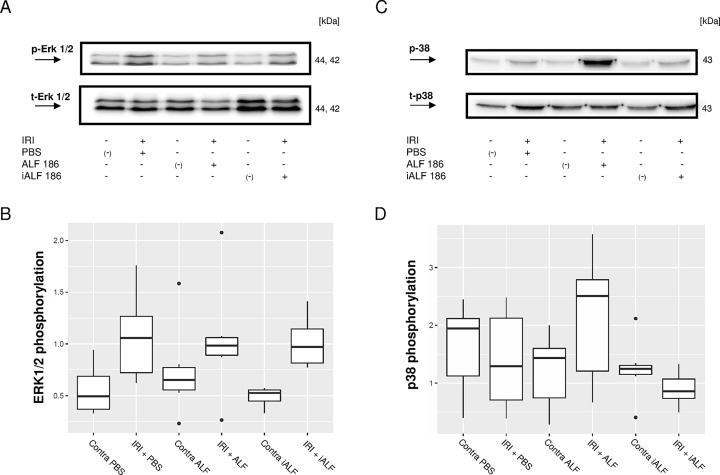
Effect of ALF-186 on mitogen-activated protein (MAP) kinases ERK1/2 and p38.(A) Representative western blot image showing the suppression of phosphorylated ERK1/2 compared to total ERK1/2 after IRI+ALF-186 treatment. The contralateral eye to each treated eye was indicated with (-) to demonstrate, that no MAP-kinase alterations were detectable in and between the right eyes. (B) Densitometric analysis of n = 6 western blots for phosphorylated ERK1/2 after IRI+treatment given in box plots. ALF-186 not affected the IRI-induced upregulation of ERK1/2, which was equally present after PBS, ALF or iALF-treatment, p>0.97. (C) Representative western blot image showing the increase of phosphorylated p38 compared to total p38 after intravitreal ALF-186 treatment. (D) Densitometric analysis of n = 7 western blots for phosphorylated p38 after IRI+treatment given in box plots. IRI+PBS vs. IRI+ALF-186, p = 0.267; IRI+ALF-186 vs. IRI+iALF-186, p = 0.032.